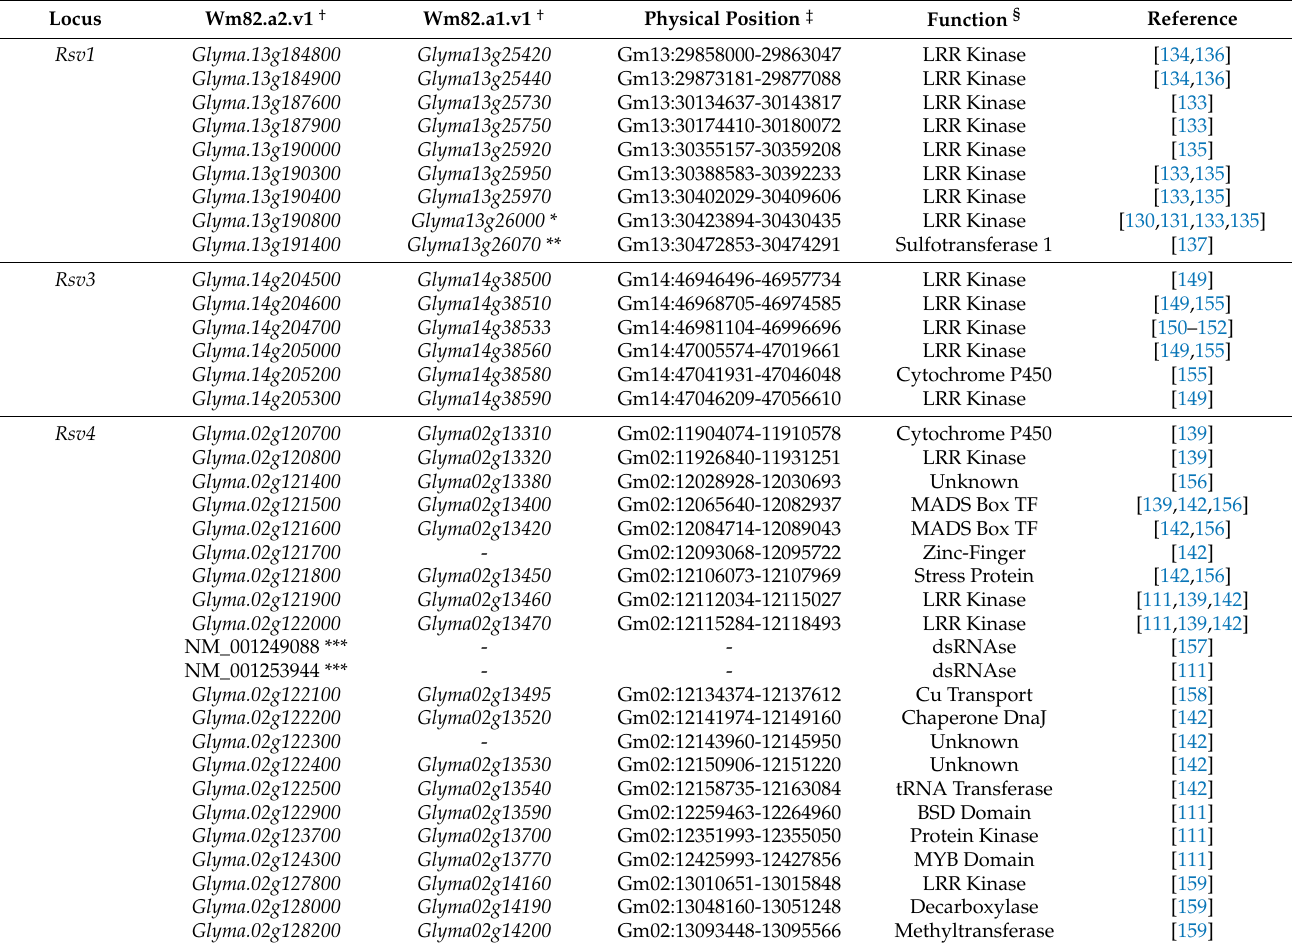
Table 3. Summary of reported SMV resistance candidate genes at Rsv1 , Rsv3 , and Rsv4